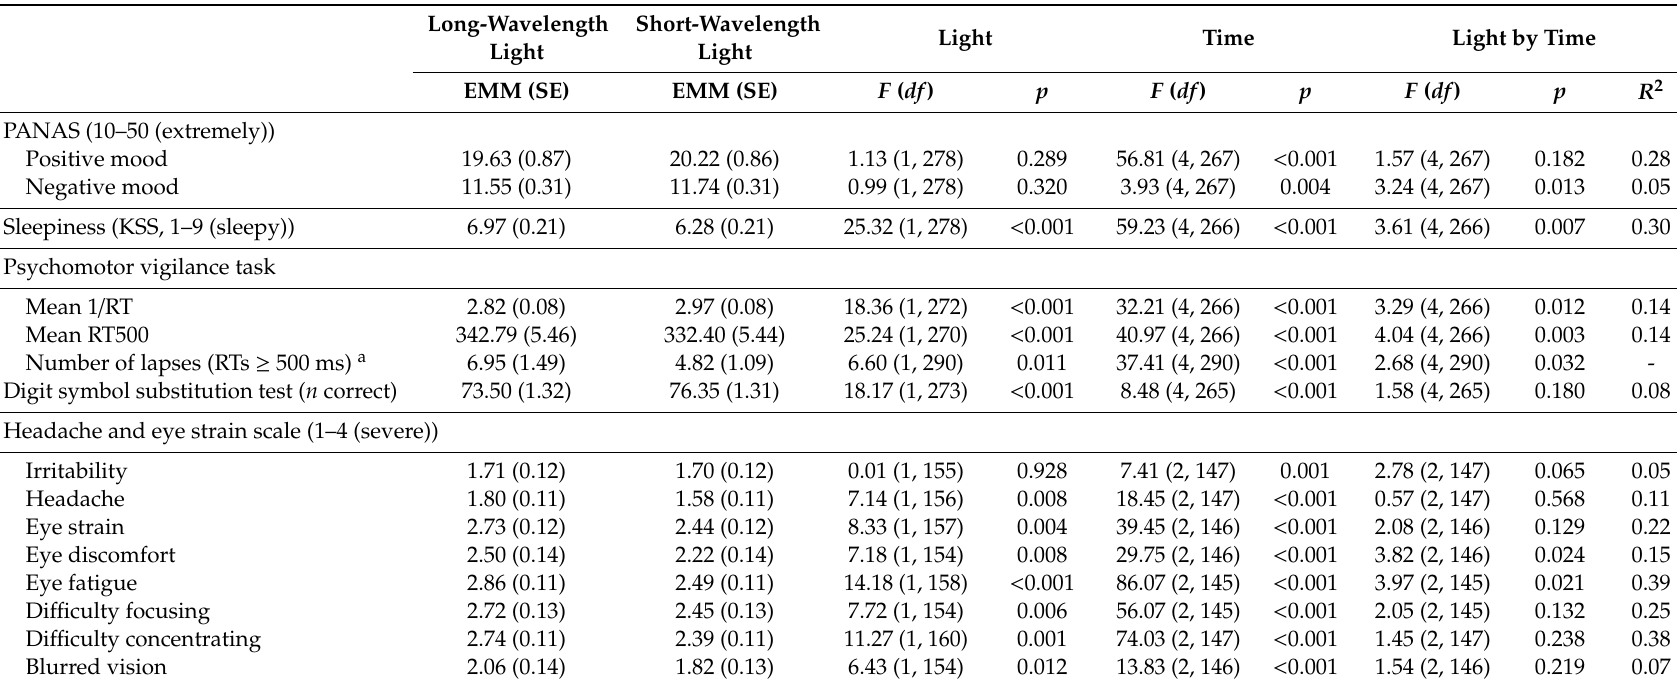
Table 2. E ff ects of light condition and time on mood, subjective sleepiness, task performance and visual comfort. Long-Wavelength Light